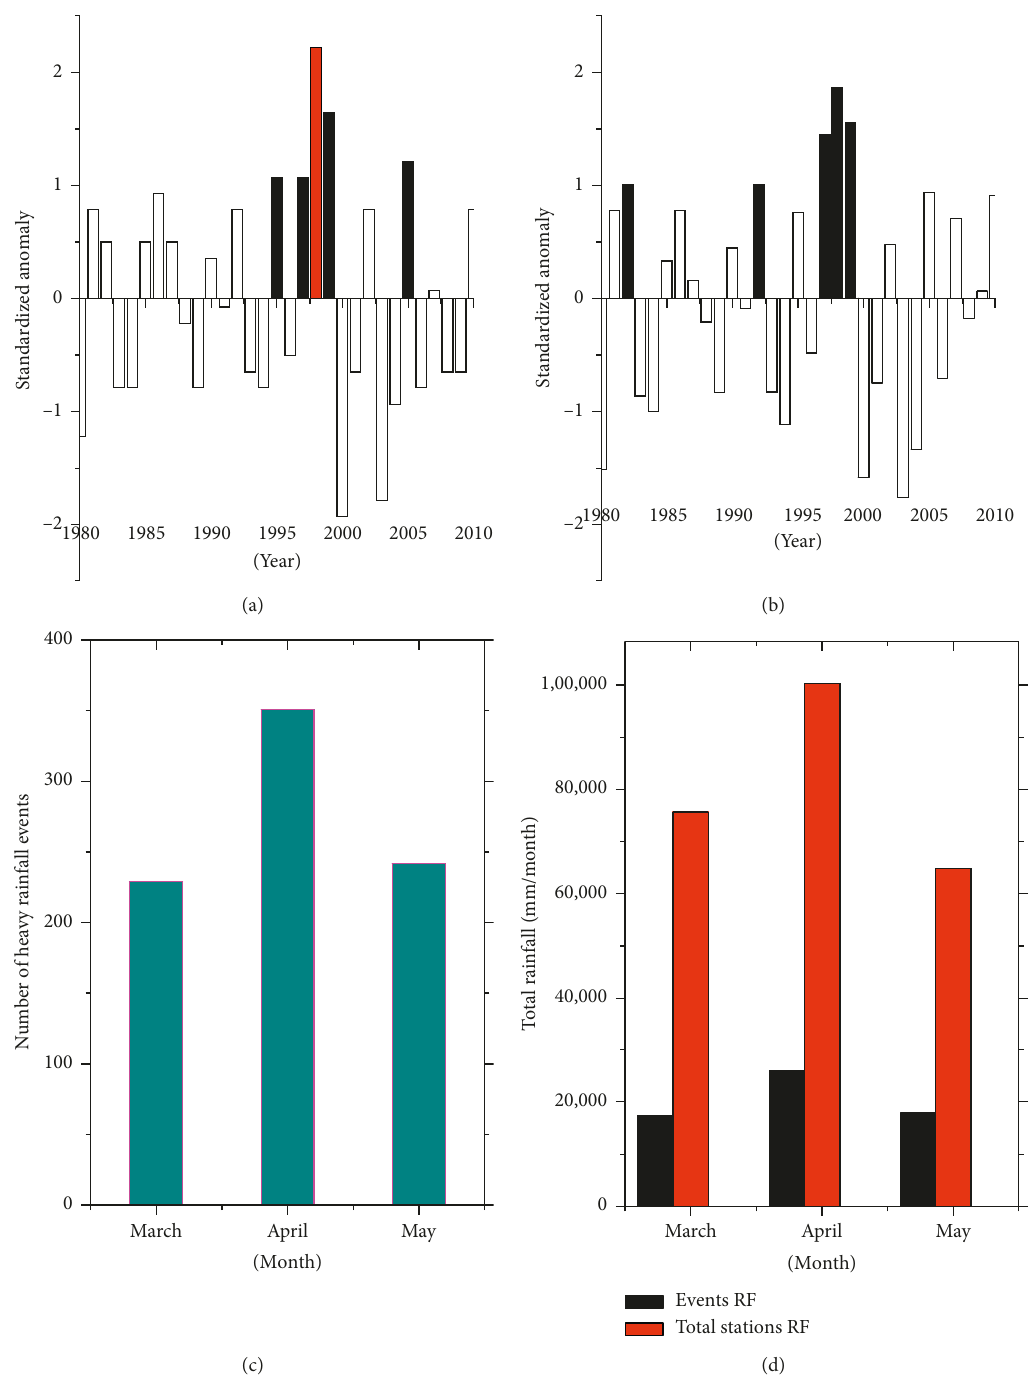
Figure 2: Interannual (top) and monthly (bottom) variability of (a, c) number of HREs and (b, d) total amount of rainfall due to HREs (mm) based on 1980–2010 climatology. Black bars in (a) and (b) represent events with standard deviation above 1, while the red bar in (a) denotes events with standard deviation above